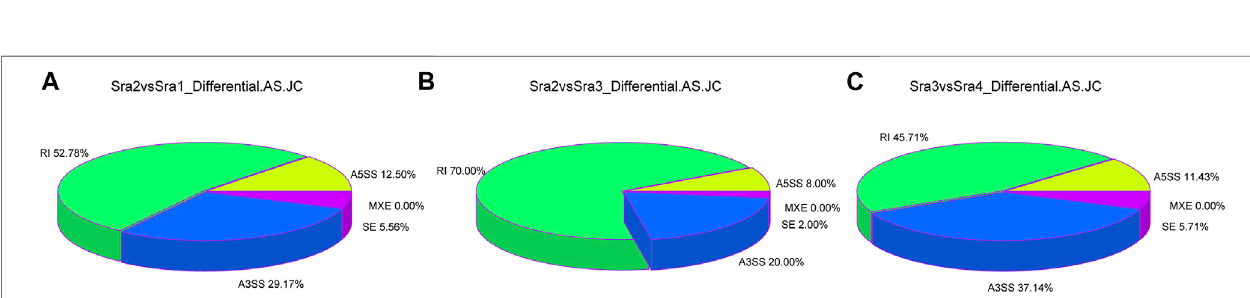
FIGURE 5 | Alternative splicing events at the different stages of S . rugosoannulata fruiting body. (A – C) Differential alternative splicing events in Sra1 vs. Sra2, Sra2 vs. Sra3, and Sra3 vs. Sra4, respectively. IR: intron retention, A5SS: alternative 5 ′ splice site, A3SS: alternative 3 ′ splice site, MXE: mutually exclusive exons, and SE: skipping